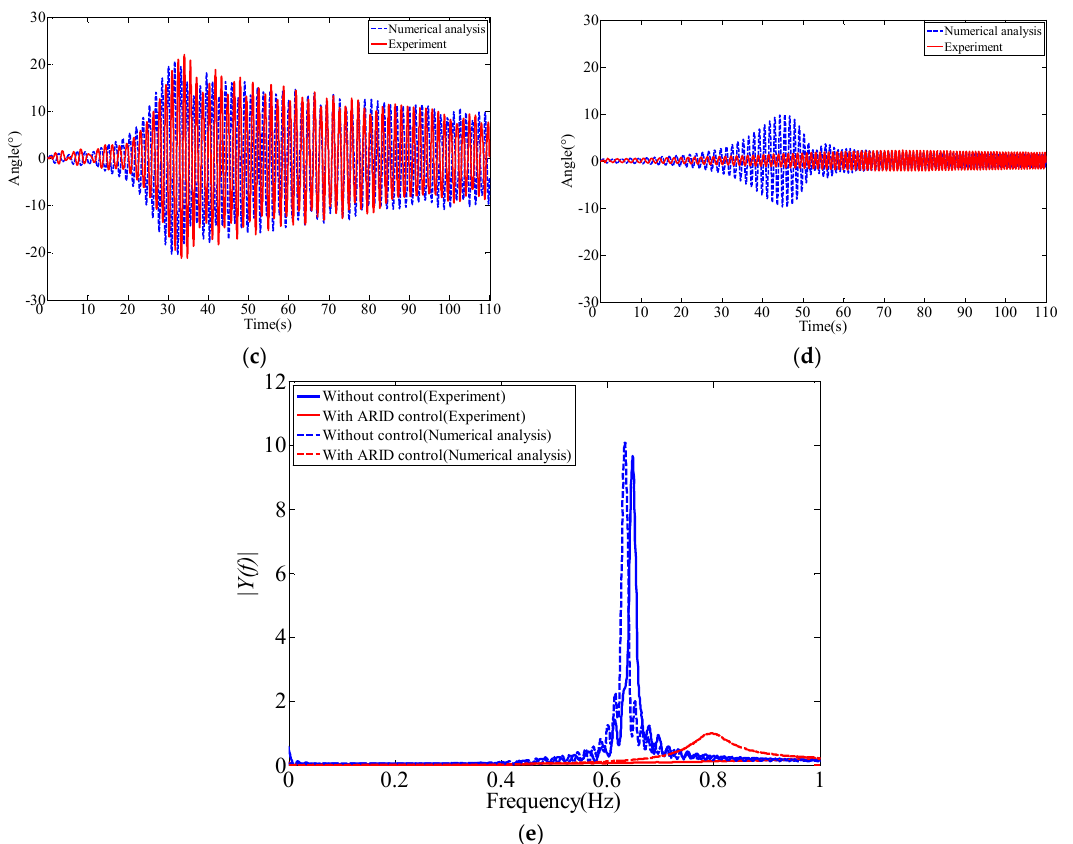
Figure 9. The experimental and numerical results of the structure with the ARID system: ( a ) Results